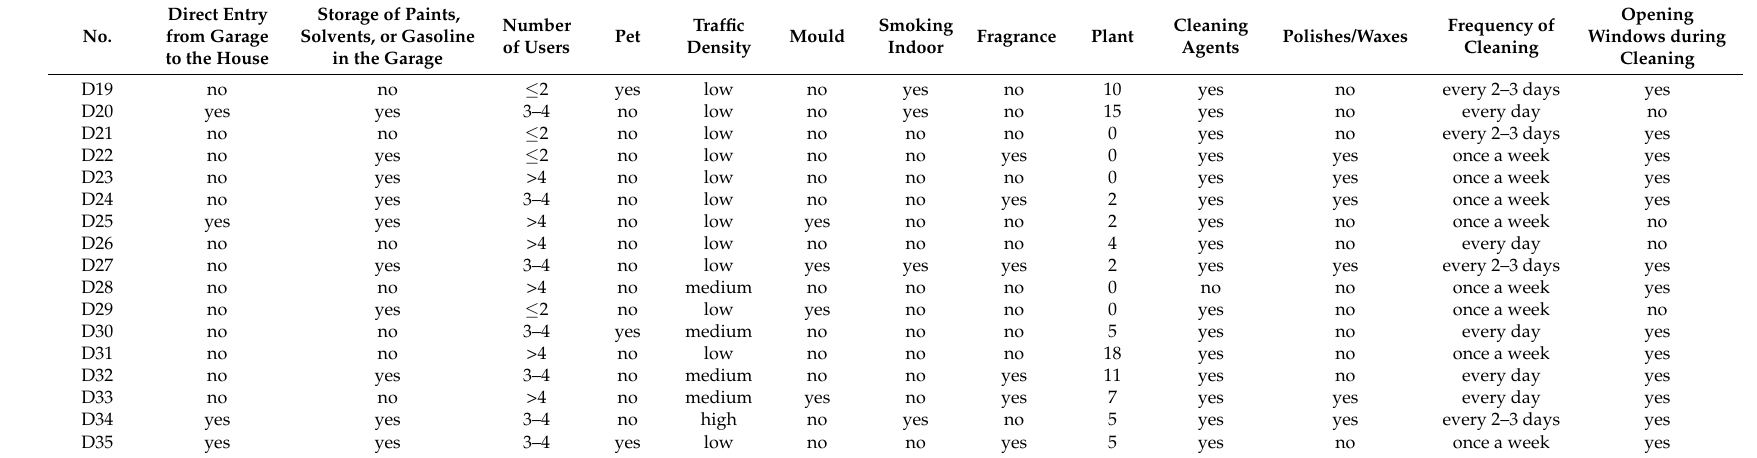
Table A4. Basic information about the family houses—Part